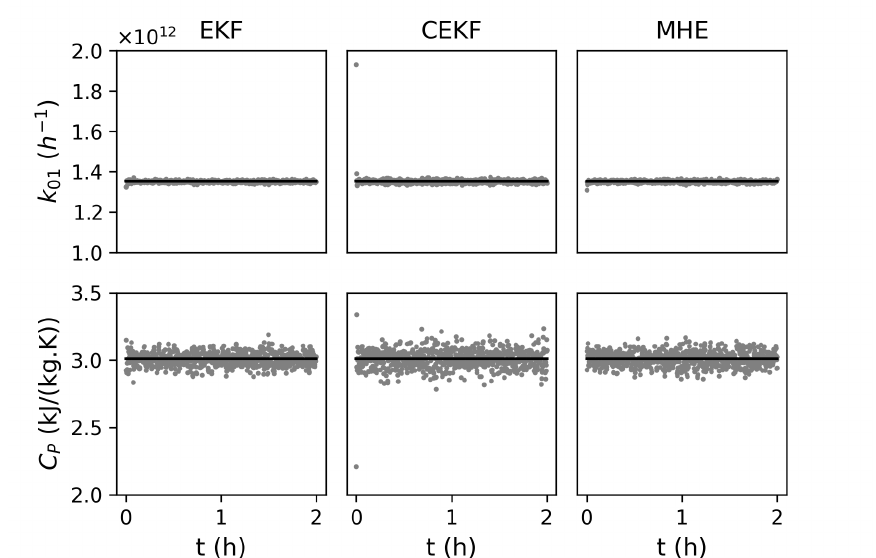
Figure 5. k 01 and C P estimations for Case 5, considering mismatch in k 01 .